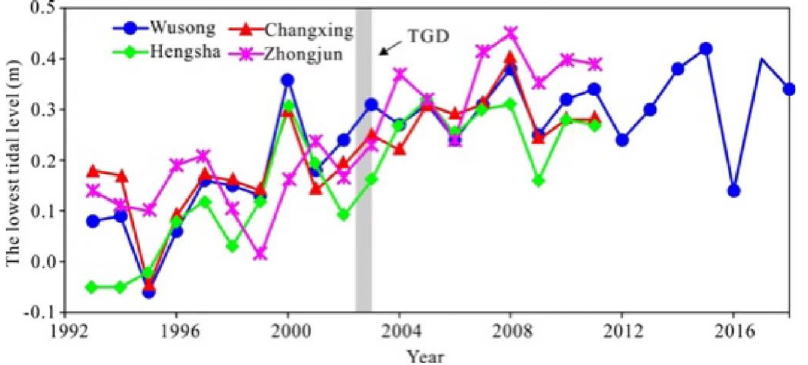
Figure 11. Annual lowest tidal level at Wusong, Changxing, Hengsha, and Zhongjun in the Yangtze River Estuary from 1992 to 2018). Note: the tidal level was obtained from Shanghai Municipal Oceanic Bureau (http://swj.sh.gov.cn/, accessed on 1 January 2022).